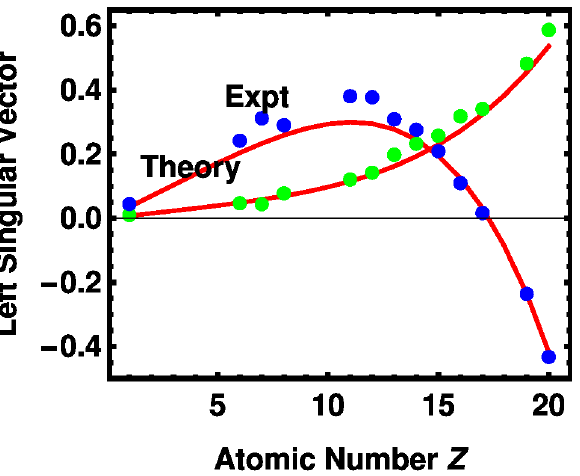
Fig 6. The components of the first two left singular vectors of the molar HU potency matrix for several elements, as indexed by the atomic number Z , are shown for theory (red lines) and experiment (first, green dots; second, blue